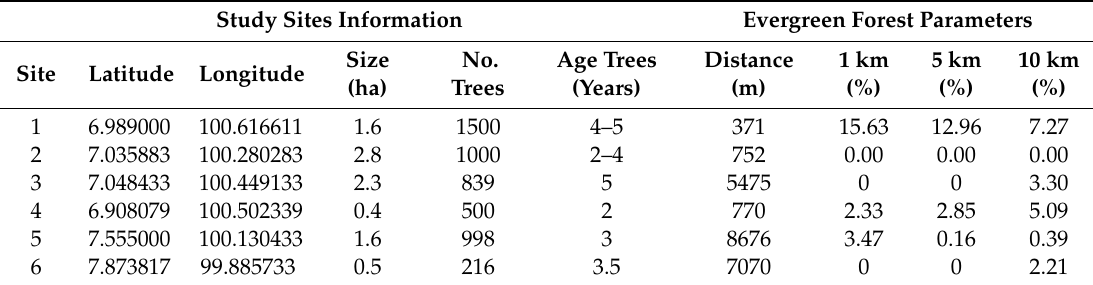
Table 1. Study site overview. General information about study sites (location, size, number and age of guava tress) and forest parameters (Distance to closest evergreen forest patch and % evergreen forest within a radius of 1, 5 and 10 km from the study